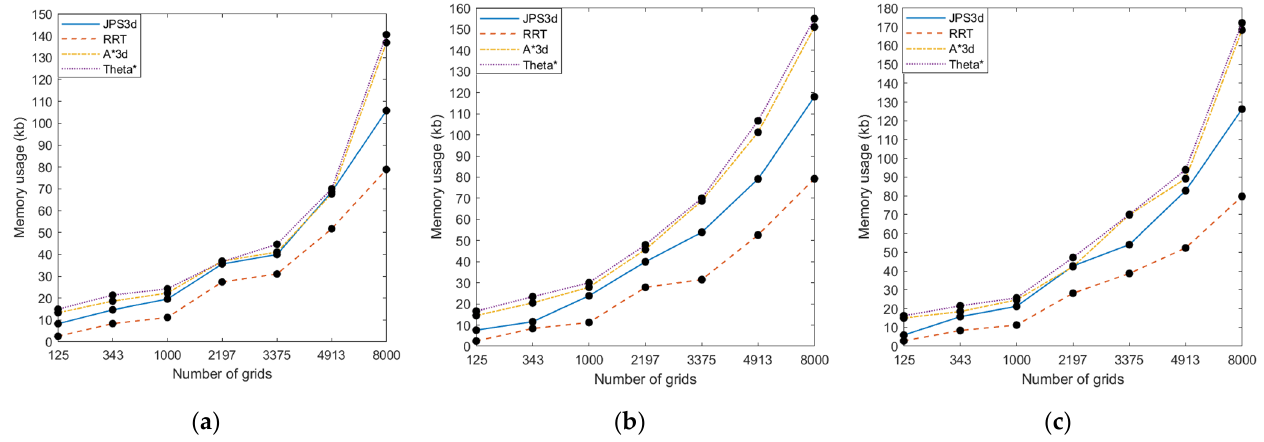
Figure 17. Algorithm memory usage comparison. ( a ) Obstacles accounted for 20%. ( b ) Obstacles accounted for 30%. ( c ) Obstacles accounted for 40%.